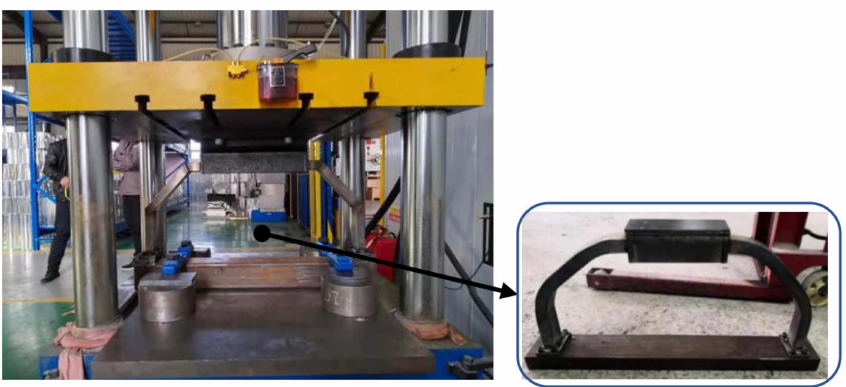
Figure 4. Drop weight loading diagram.